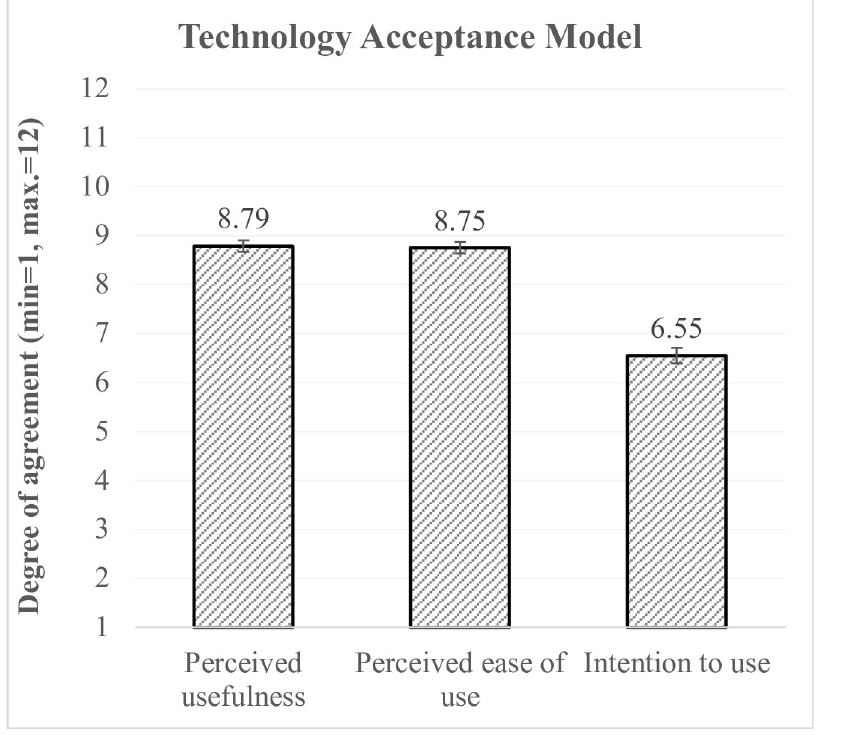
Fig 6. Evaluations of the technology acceptance criteria according to TAM